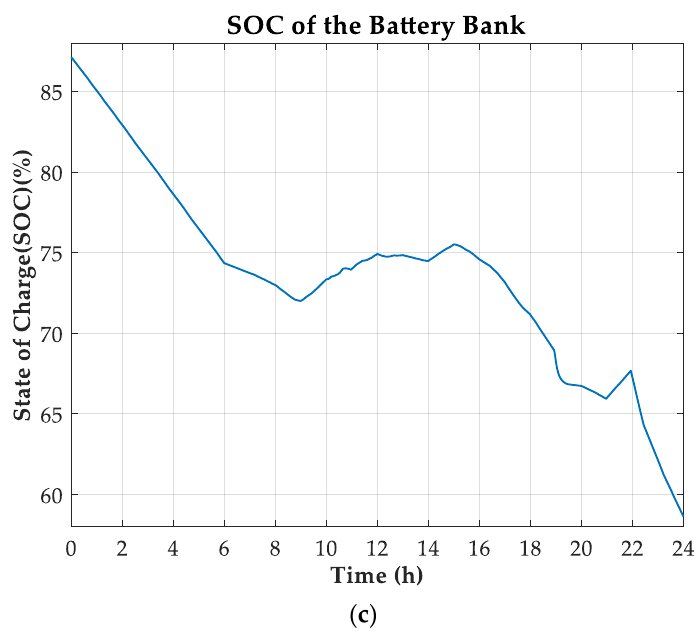
Figure 14. Results of the simulation of the PV / Stirling / battery system. ( a ) Generated power; ( b ) supplied power; and ( c ) state of charge of the battery bank on June 21.